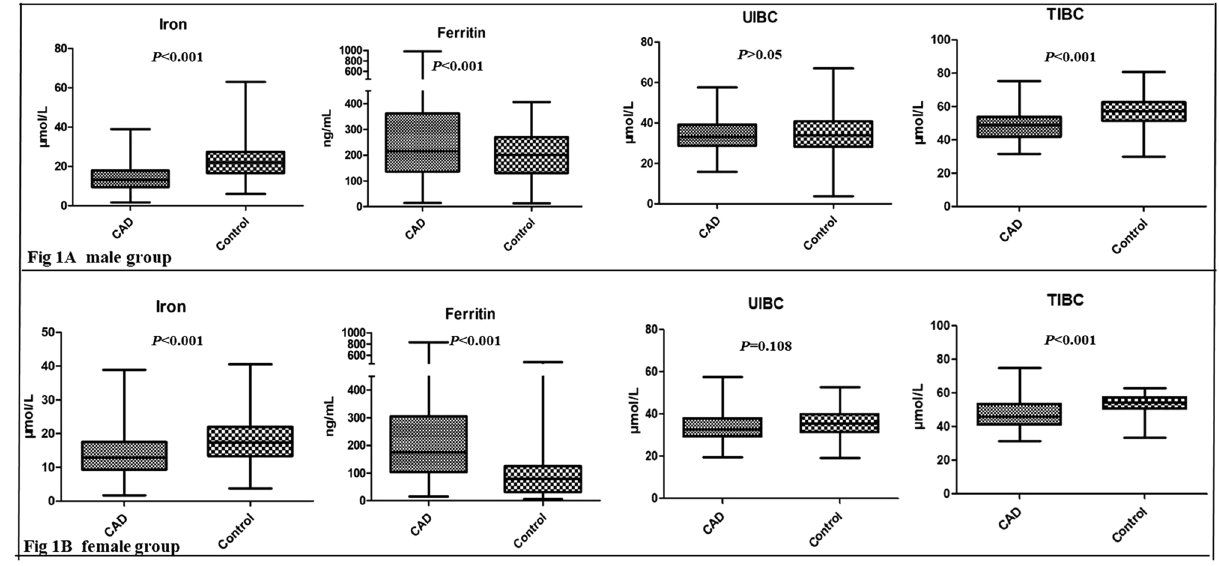
Figure 1. Serum iron metabolism markers.